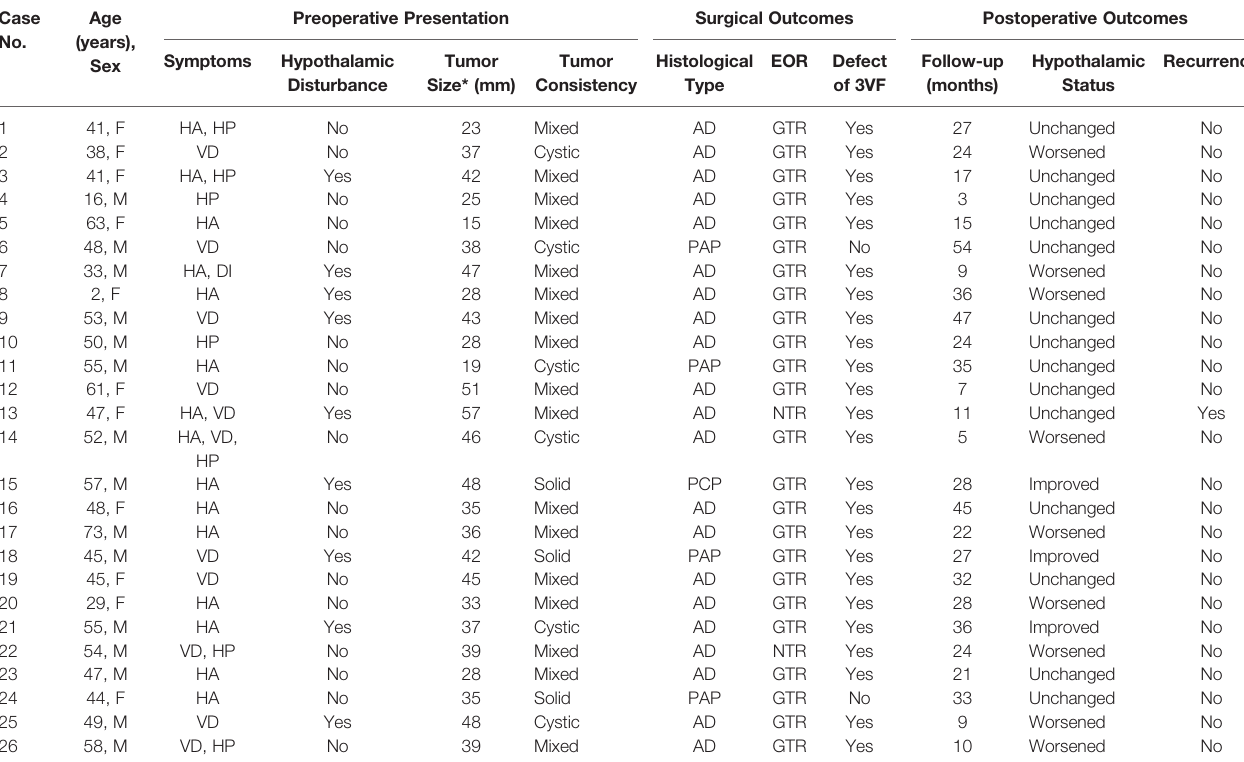
TABLE 1 | Clinical chart of each enrolled